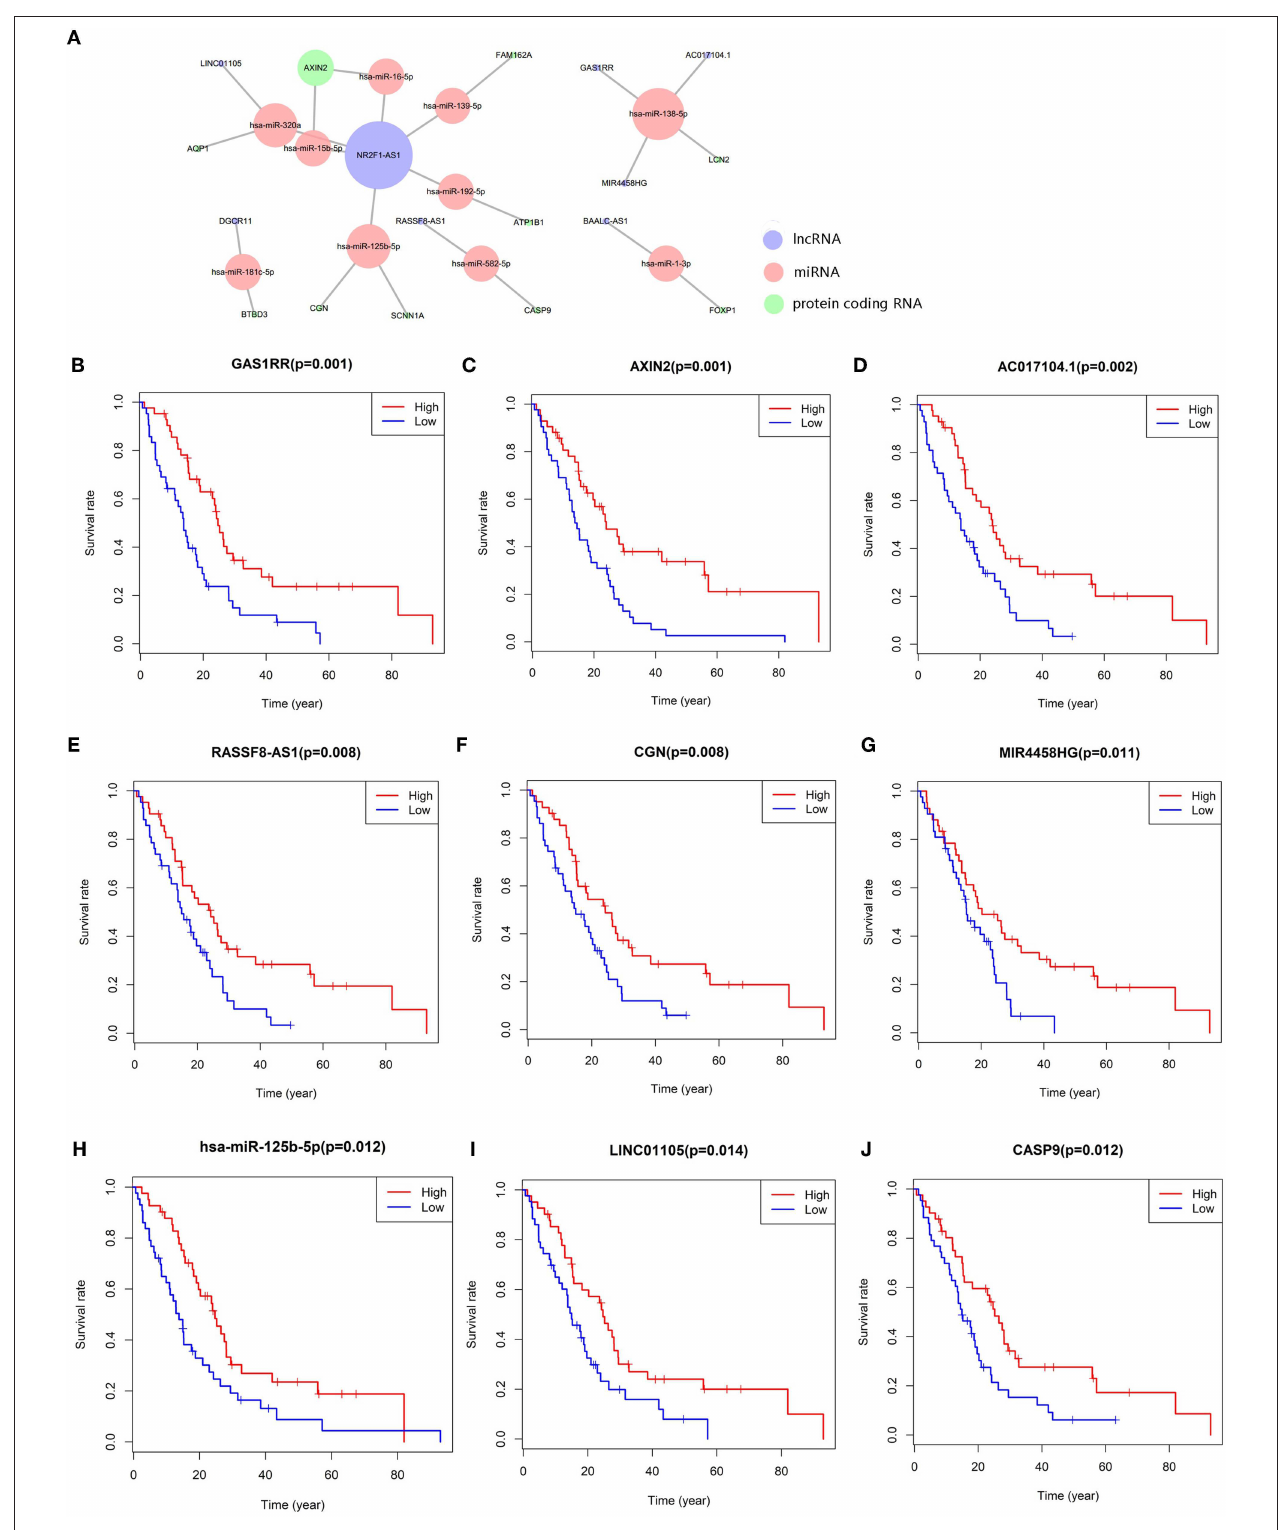
FIGURE 3 | The meso-bone metastasis related ceRNA network (A) ; the Kaplan–Meier survival curves of the key members of the ceRNA network: GAS1RR (B) , AXIN2 (C) , AC017104.1 (D) , RASSF8-AS1 (E) , CGN (F) , MIR4458HG (G) , hsa-miR-125b-5p (H) , LINC01105 (I) , and CASP9 (J) .